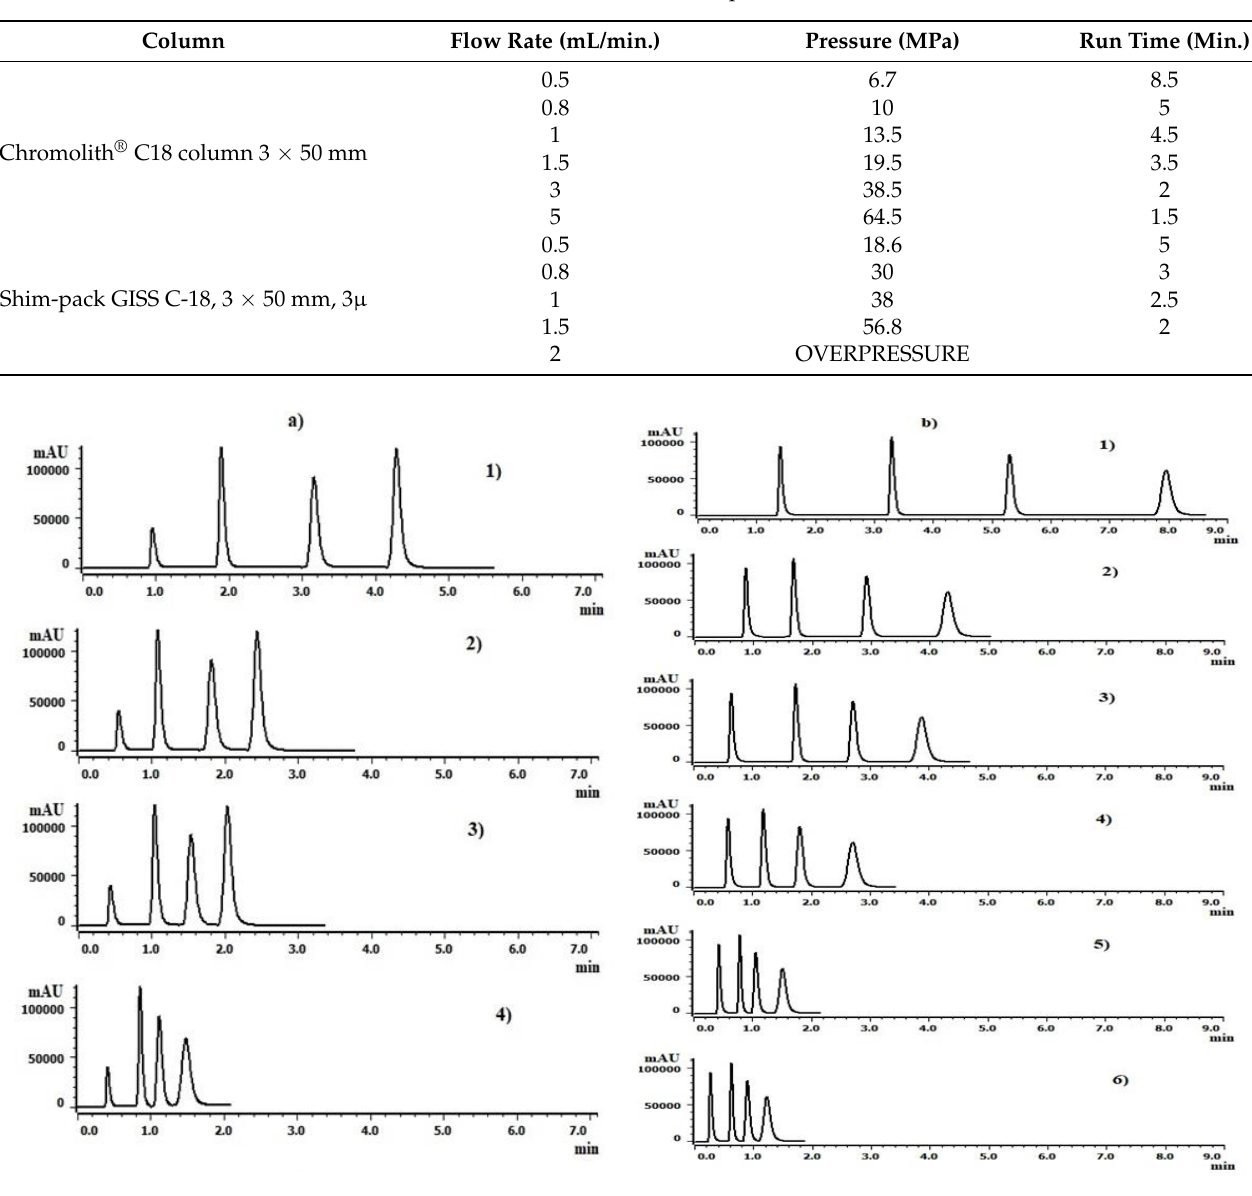
Table 2. The influence of flow rates on the backpressure of the instrument.